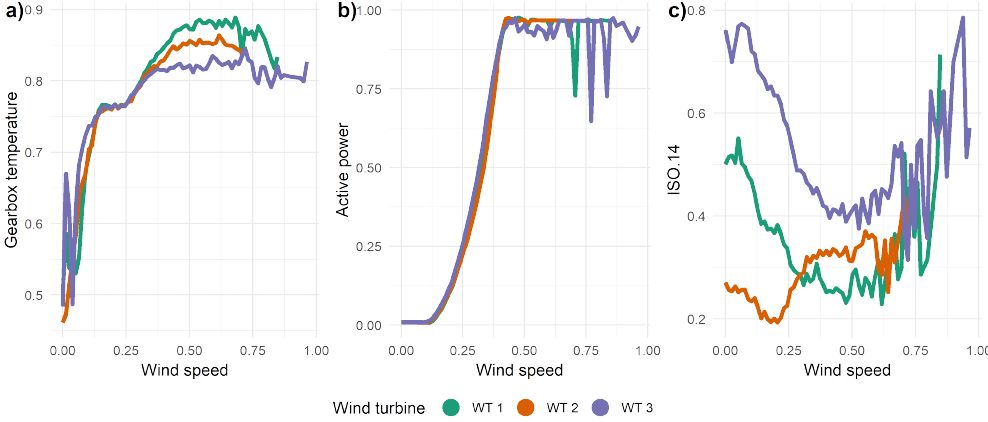
Figure 3. Averaged values of gearbox temperature, active power and ISO.14 in 0.33 m/s wind speed bins. ( a ) Gearbox temperature. ( b ) Active power. ( c ) ISO.14.